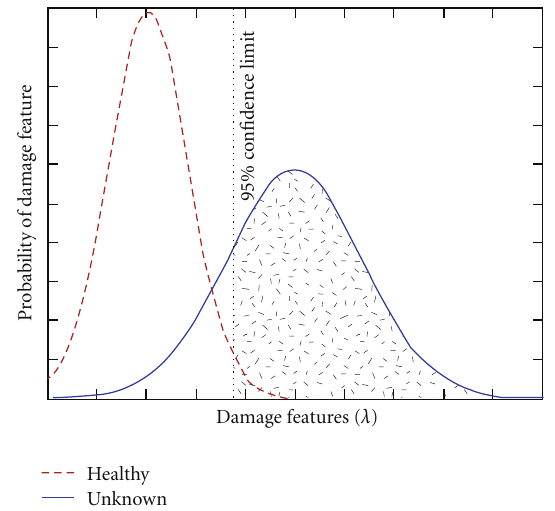
Figure 7: Schematic representation of probability of damage. Hatched area represents the cumulative probability of damage representing the neural-wavelet damage metric Γ NW